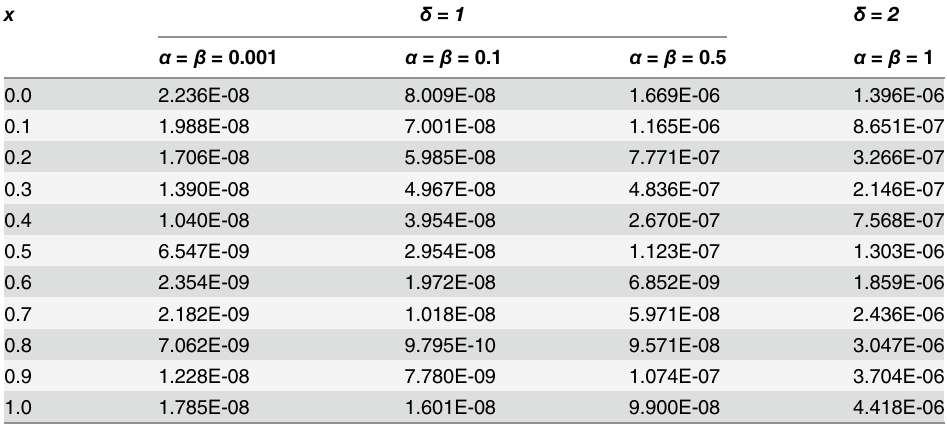
Table 4. The absolute errors for example 1 for different values of α , β , δ and for time t = 0.1.